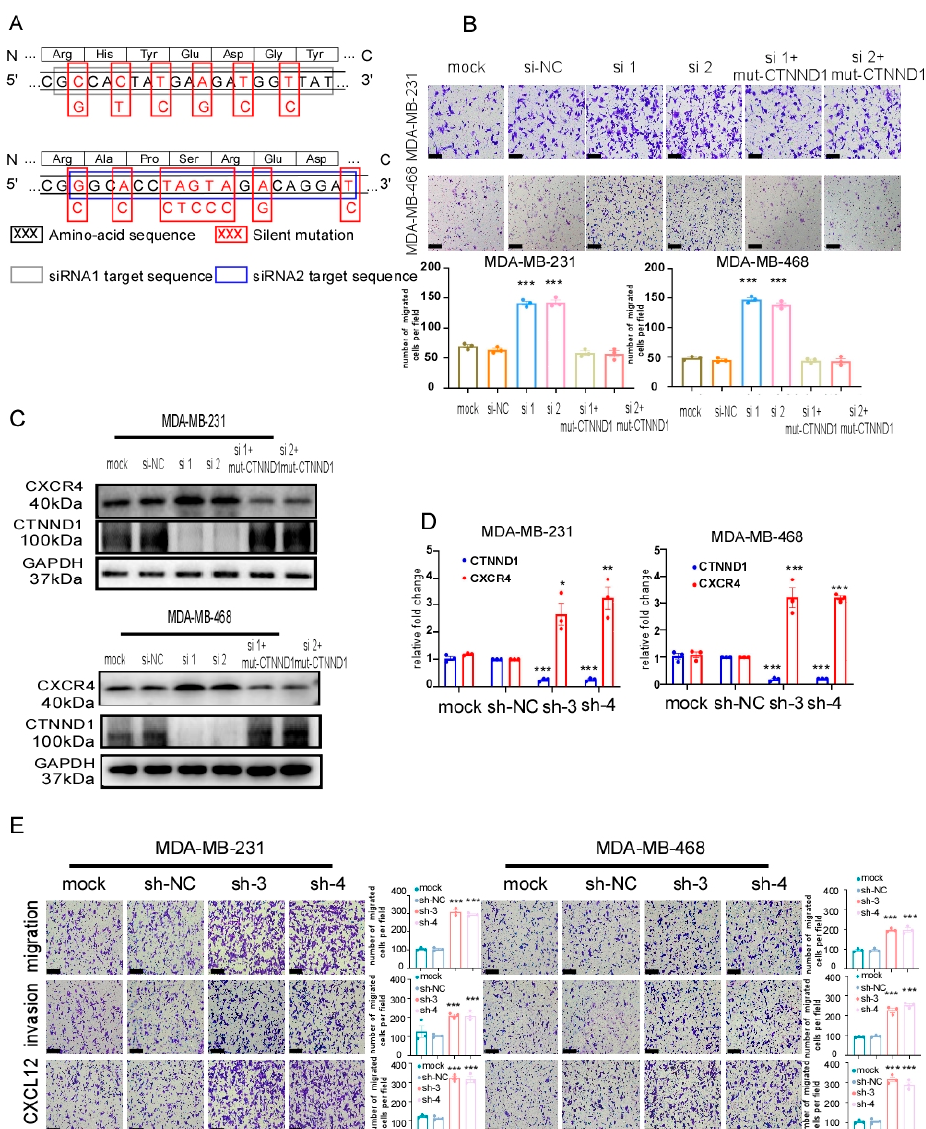
Figure A2. ( A ) Cartoon exemplifying the silent mutations in the siRNA1 and siRNA2 target sequence of WT CTNND1 cDNA, which confer resistance to the siRNA1 and siRNA2 and no change in the amino-acid sequence of the resulting protein (mut-CTNND1), compared with the WT. ( B ) Images and quantification of chemotaxis of MDA-MB-231 and MDA-MB-468 cells expressing mut-CTNND1 despite co-transfection with siRNA1 and siRNA2. ( C ) Immunoblot of CTNND1 and CXCR4 in MDA-MB-231 and MDA-MB-468. Note the strong expression of CTNND1 in cells expressing mut-CTNND1 despite co-transfection with siRNA1 and siRNA2. ( D ) Expression of CTNND1 and CXCR4 by qRT-PCR in MDA-MB-231 and MDA-MB-468 transfected with the other two sh-CTNND1 plasmids. ( E ) Images and quantification of transwell migrated and invaded cells after CTNND1 knockdown by being transfected with the other two sh-CTNND1 plasmids. Scale bar represents 200 μ m. All experiments were repeated at least 3 times. * p < 0.05, ** p < 0.01, *** p < 0.005. Error bars indicate Standard Error of Mean (S.E.M.).